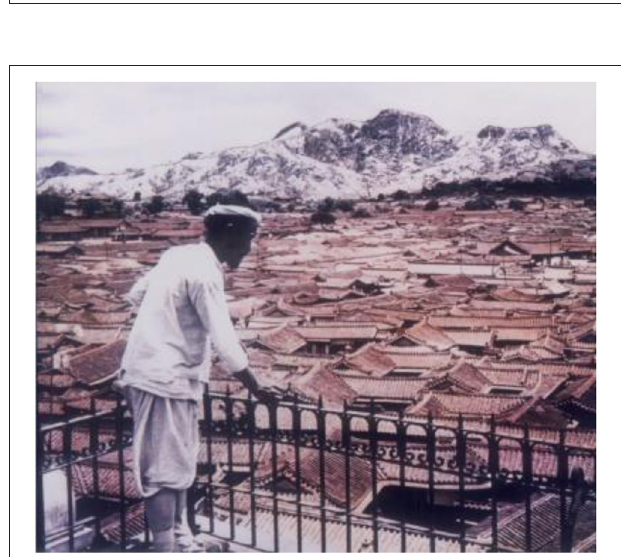
FIGURE 1 | Historical map of Seoul, produced between A.D. 1890–1897. Reproduced courtesy of Seoul Museum of History. Locations, where recorded, of potential leopard sightings (1870–1900) marked in red, with date of sighting provided.